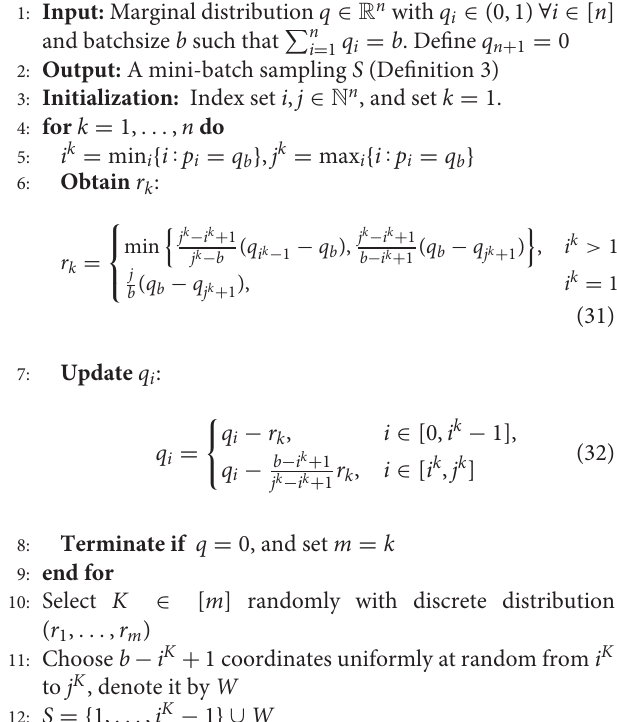
Algorithm 3 Non-uniform mini-batch